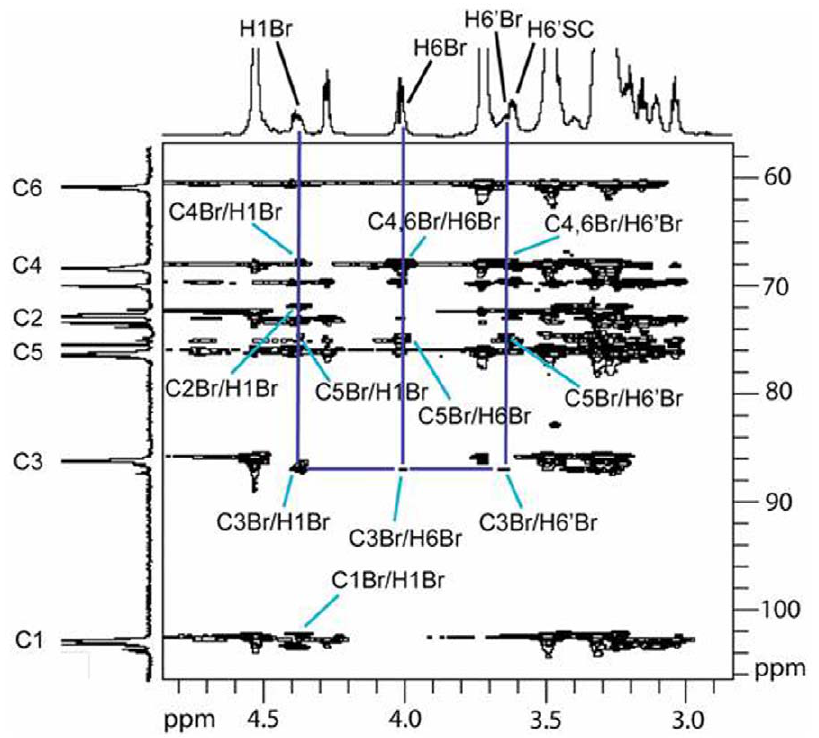
Figure 3. Assignment of 13 C and 1 H chemical shifts for the branchpoint repeat unit of the (1 R 3,1 R 6)- b -D-glucan isolated from C.glabrataace2 strain. HSQC-TOCSY spectrum indicates assignments and correlations for protons and carbons in the branch point repeat unit based upon correlations initially identified for C3Br (Figure 2).